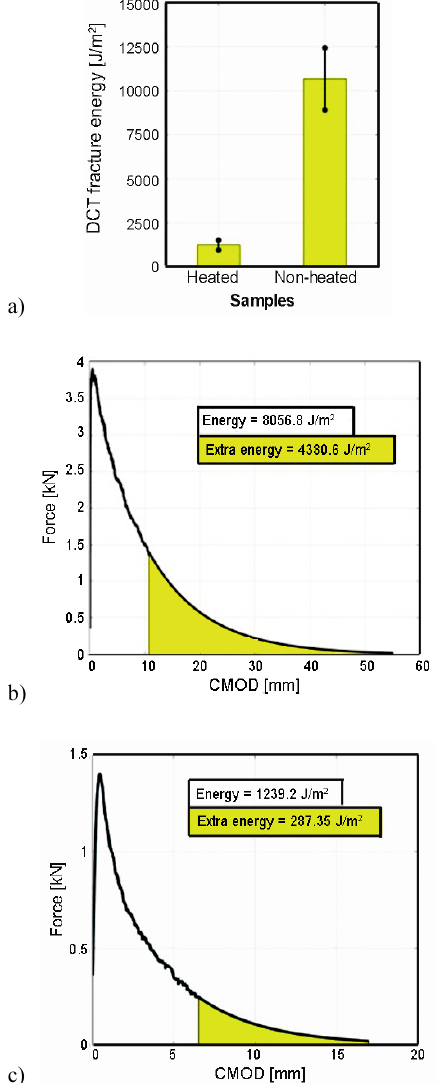
Fig. 6. Disc-Compact Tension Test (DCT) results: a) The total fracture energy for DCT specimens cut from zones at the top of cylinders, star markers indicate the value range, the bar presents the mean value; b) Example of Load-CMOD curve for unheated DCT specimens; c) Example of Load-CMOD curve for heat treated DCT